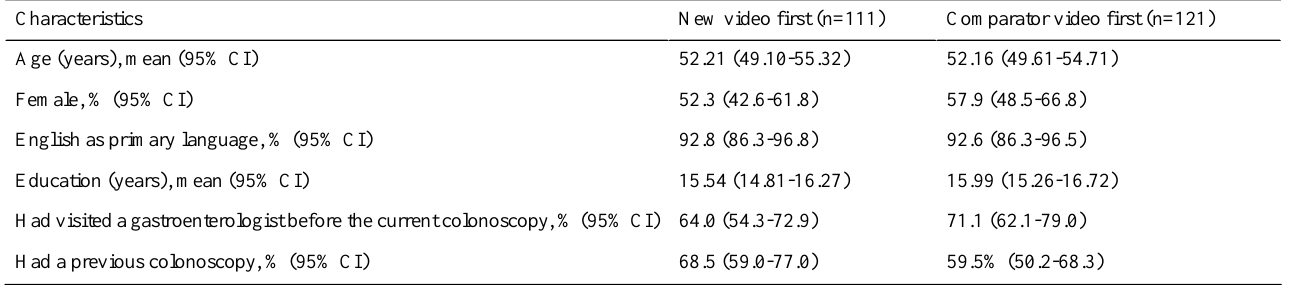
Table 1. Sociodemographic characteristics of respondents.